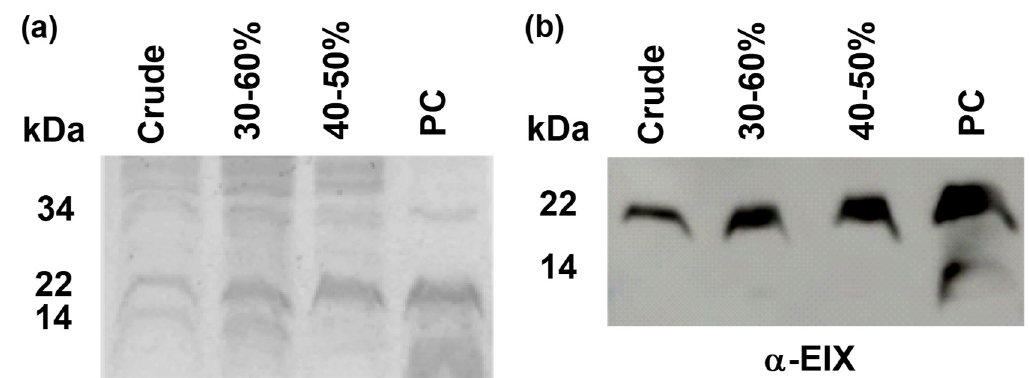
Figure 1. Verification of Ethylene Inducing Xylanase (EIX) presence and evaluation of purification level. Equal amounts of extracts and positive control were loaded onto 16% SDS-PAGE. ( a ) Coomassie staining. Gel was submerged in staining solution for 30 min and later de-stained overnight. ( b ) Western blot. Gel was blotted onto a nitro-cellulose membrane and subsequently incubated with polyclonal anti-EIX antibodies Adapted from [29].